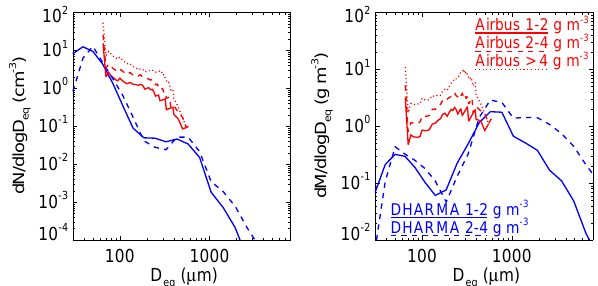
Figure 3. Particle size distributions in terms of number ( N , left) and mass ( M , right) as functions of area-equivalent particle diameter ( D eq ) obtained during Airbus flight test out of Cayenne (red lines) and from DHARMA-bin simulations (as in Fig. 2; blue lines). Dif- ferent line patterns correspond to IWC ranges as indicated. Airbus measurements encompass flight 1423, as discussed at length and shown in Figs. 4–6 of Part 1. DHARMA-bin results are from a hor- izontal line spanning the 88km wide domain through the point of maximum IWC at 11.7km ( − 43.7 ◦ C) at 21:40UTC on 23 January 2006, typical of mature convection in the